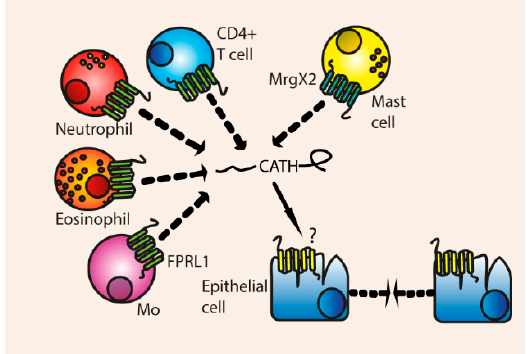
Figure 4. Direct induction of chemotaxis and cellular migration. Cathelicidins induce migration of T cells, neutrophils, eosinophils and monocytes through the FPRL1 receptor. Mast cell chemotaxis is induced through the MrgX2 receptor. Additionally, epithelial cells are induced to migrate through unknown receptors.